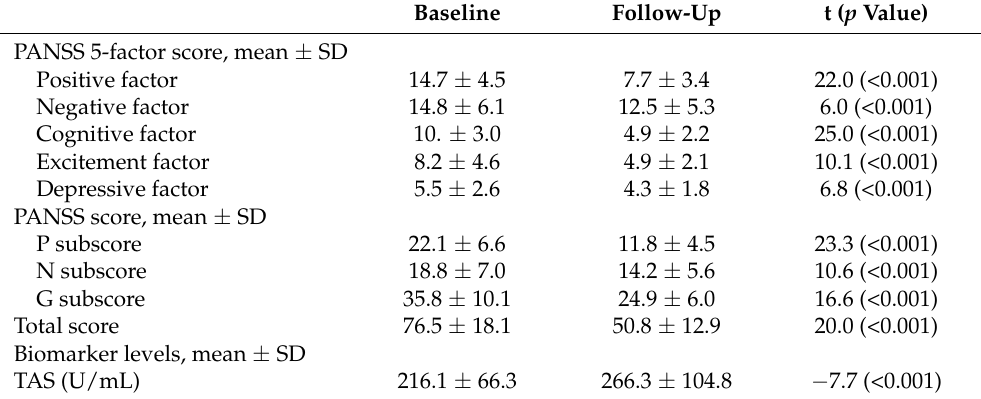
Table 3. Comparisons of clinical symptoms before and 3 months after risperidone monotherapy.